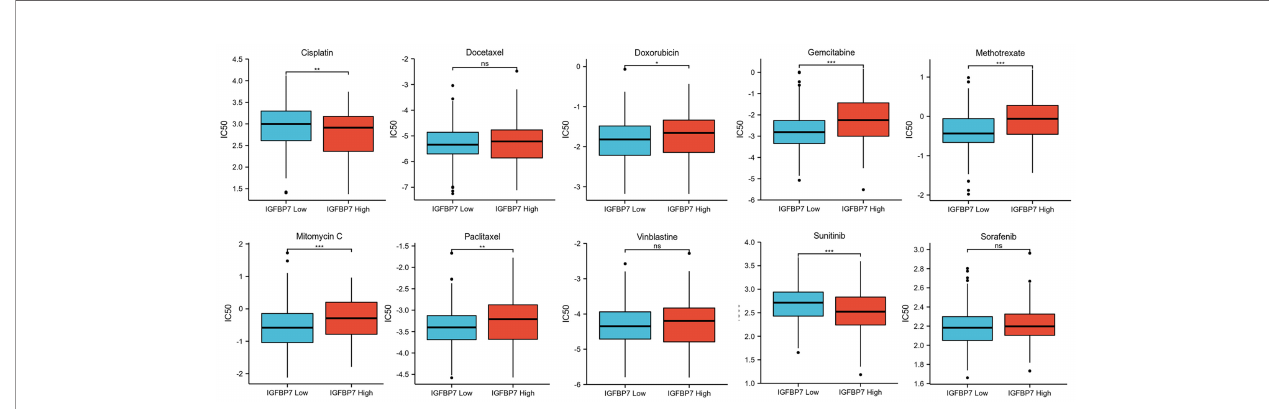
FIGURE 5 | IC50 of chemotherapy drugs and tyrosine kinase inhibitors in bladder cancer based on IGFBP7 expression. *p< 0.05; **p<0.01; ***,p<0.001. ns, no signi fi cance; ns, p ≥ 0.05,